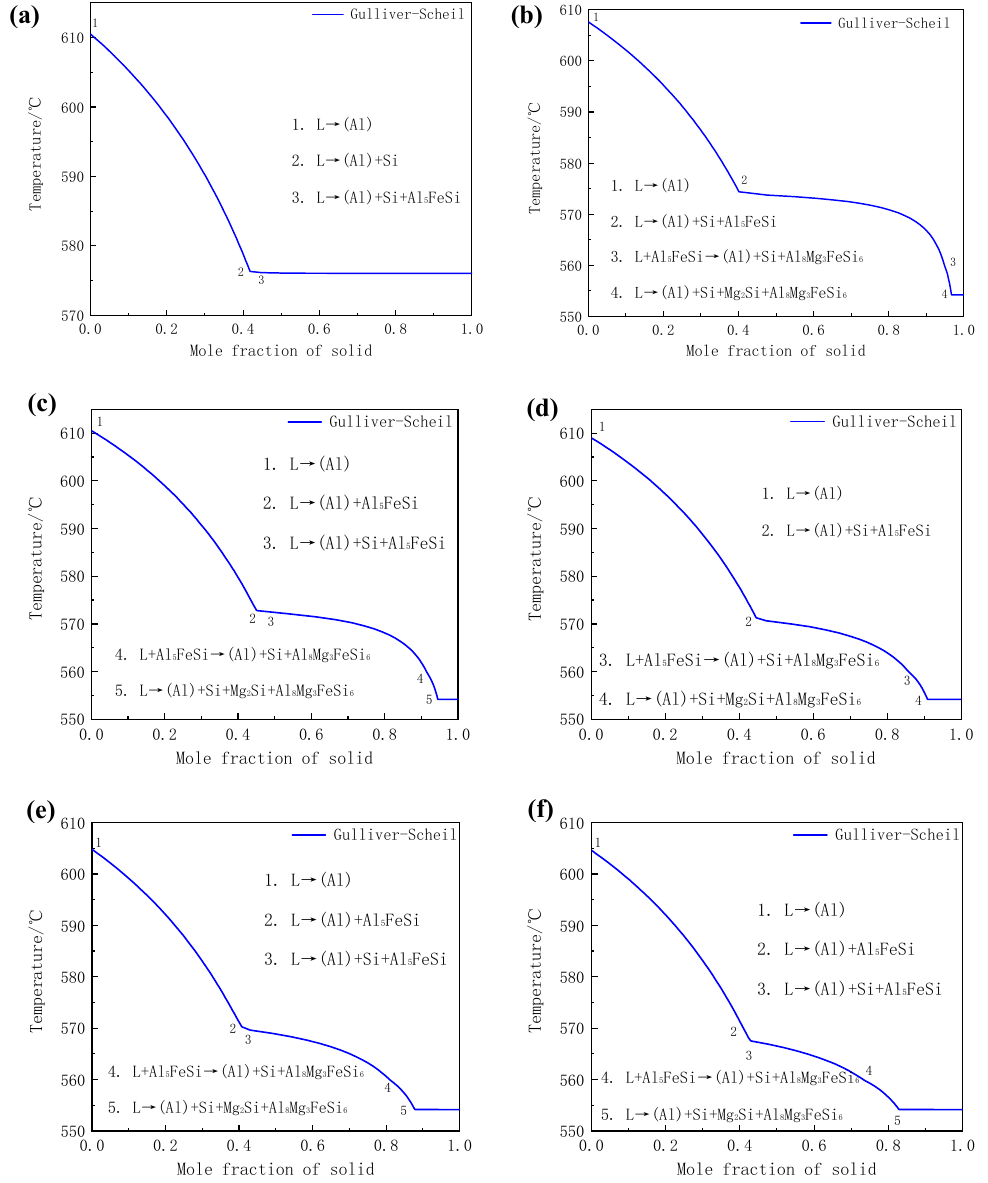
Figure 4. Calculated solidification curves of Al-8Si-xMg alloys under Gulliver-Scheil non-equilibrium conditions ( a ) without Mg and with ( b ) 0.33% Mg, ( c ) 0.51% Mg, ( d ) 0.78% Mg, ( e ) 0.99% Mg, and ( f ) 1.32% Mg.